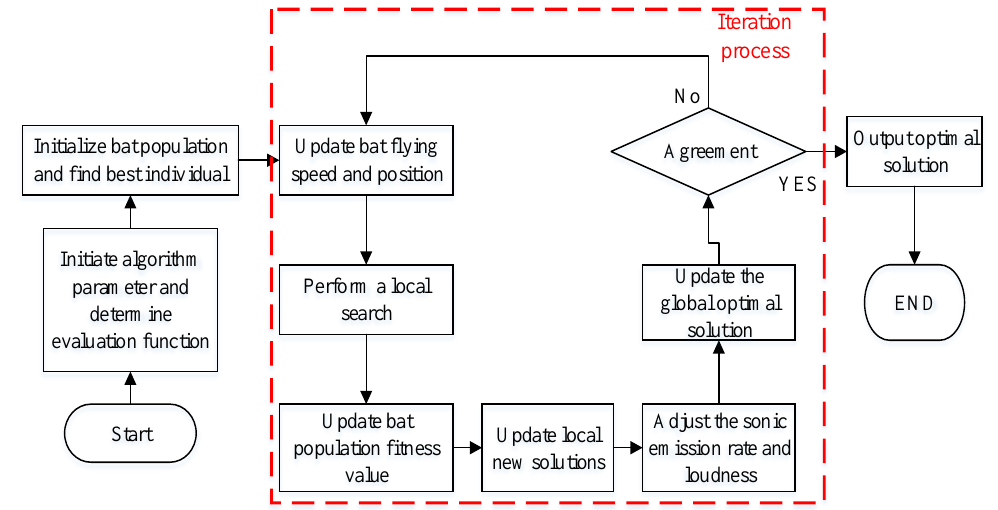
Figure 11. Logic diagram of basic bat algorithm.